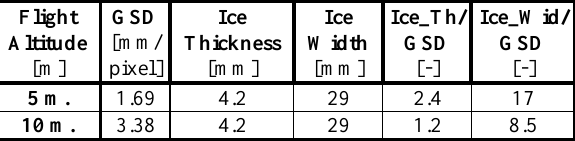
Table 6. Ground sample